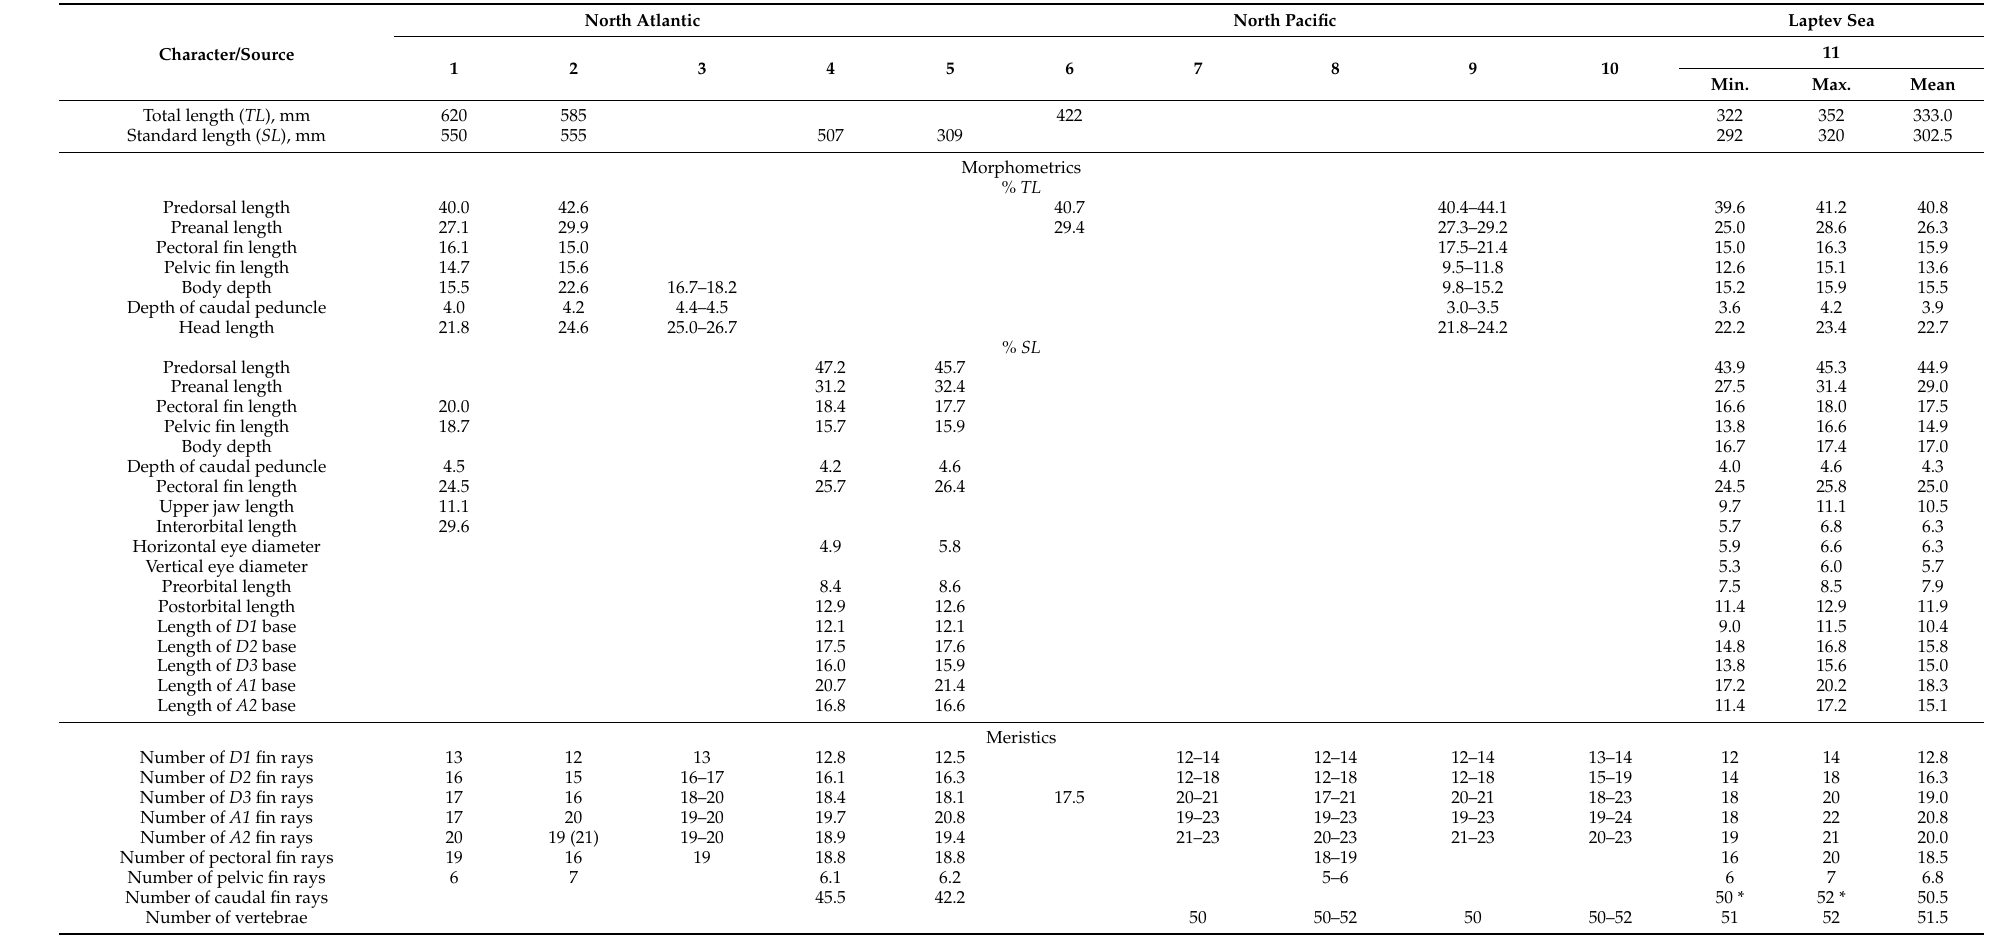
Table 3. Morphometric and meristic characteristics of walleye pollock Gadus chalcogrammus from various parts of species’